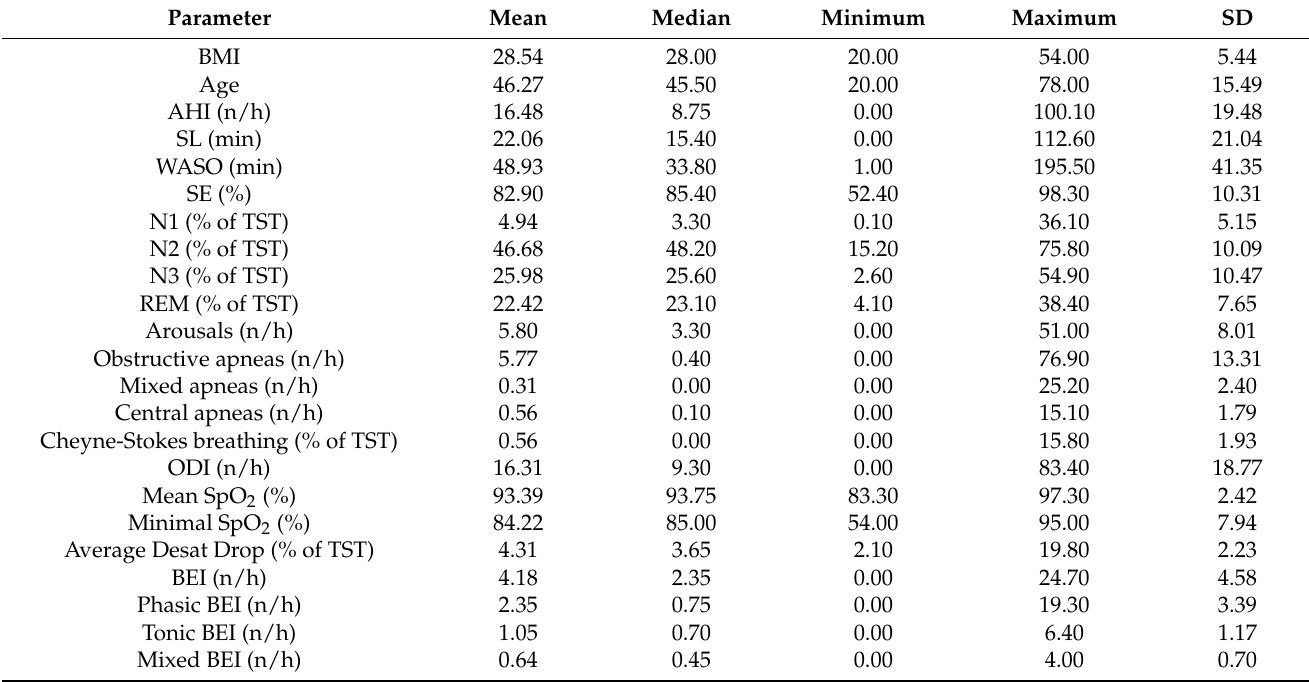
Table 1. Group characteristics and mean values of polysomnographic